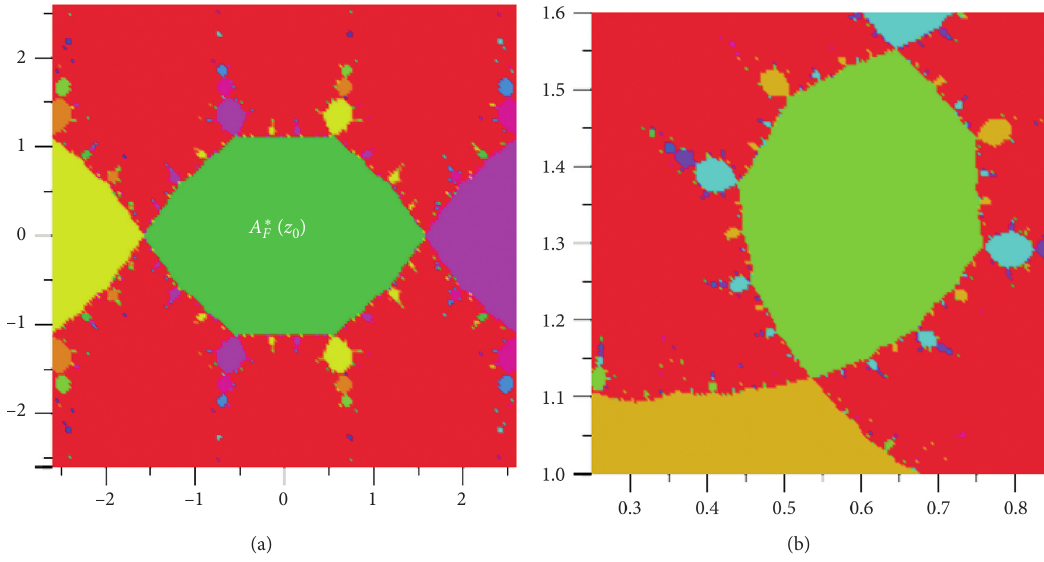
Figure 5: (a) Primary basin of attraction of F